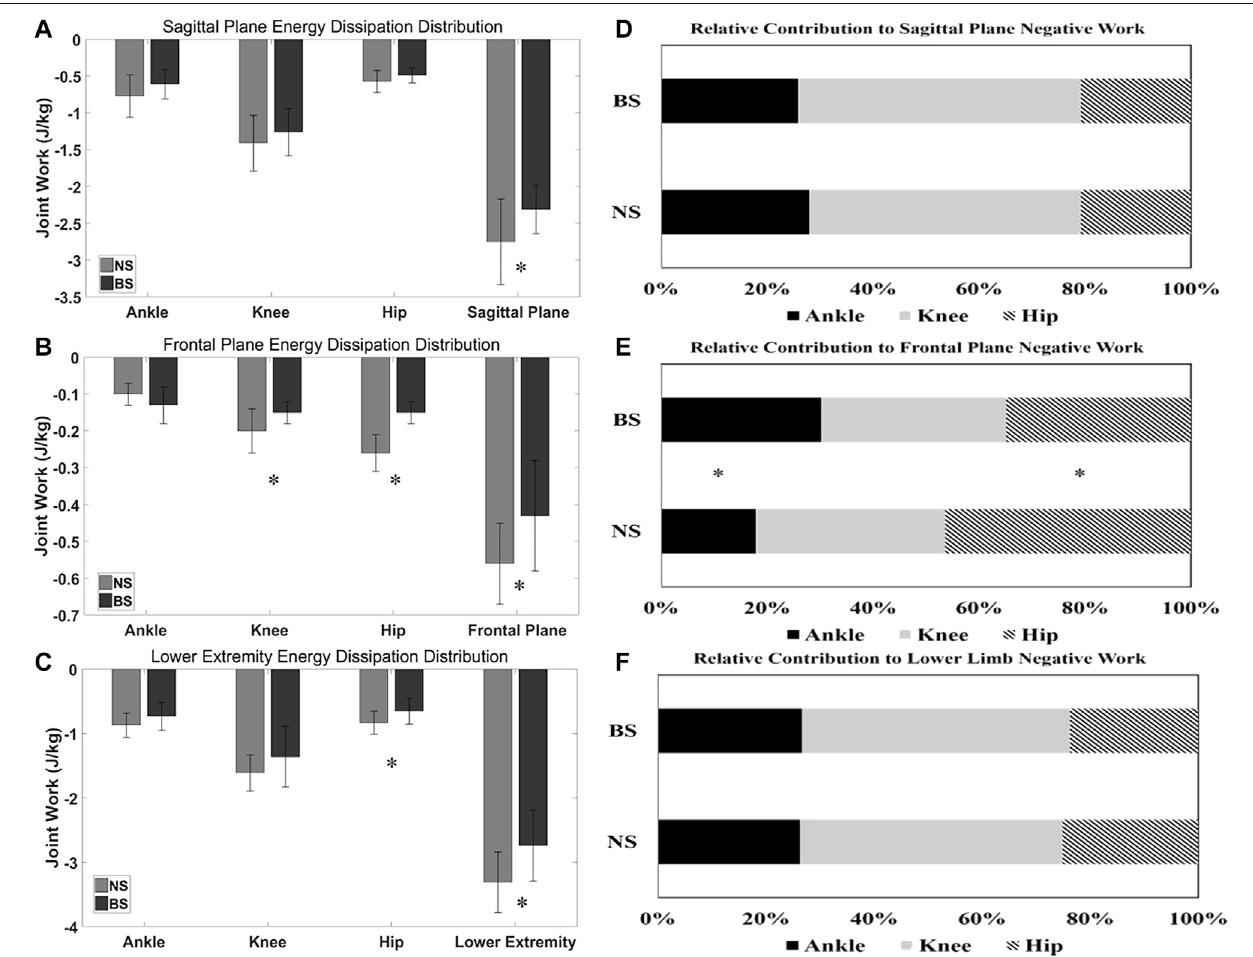
FIGURE3| Comparisonofmeanenergydissipationandcontributiontototalenergydissipationinthesagittalplane,frontalplane,andlowerextremitybetweenNS and BS during single-landing phase. * refer to the signi fi cant difference between NS and BS ( p < 0.05).